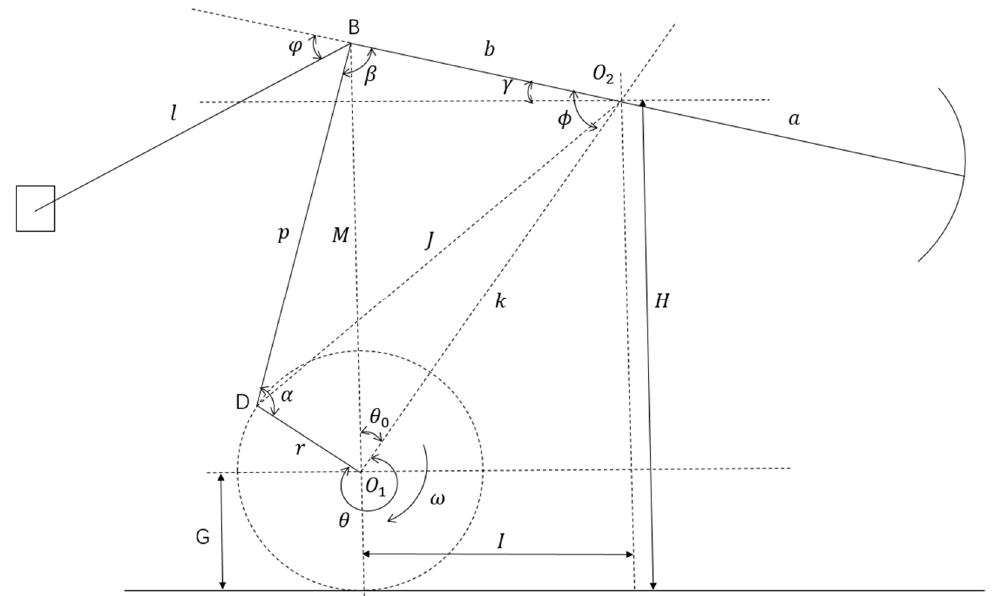
Figure 3. Geometric structure of the variable torque pumping unit.